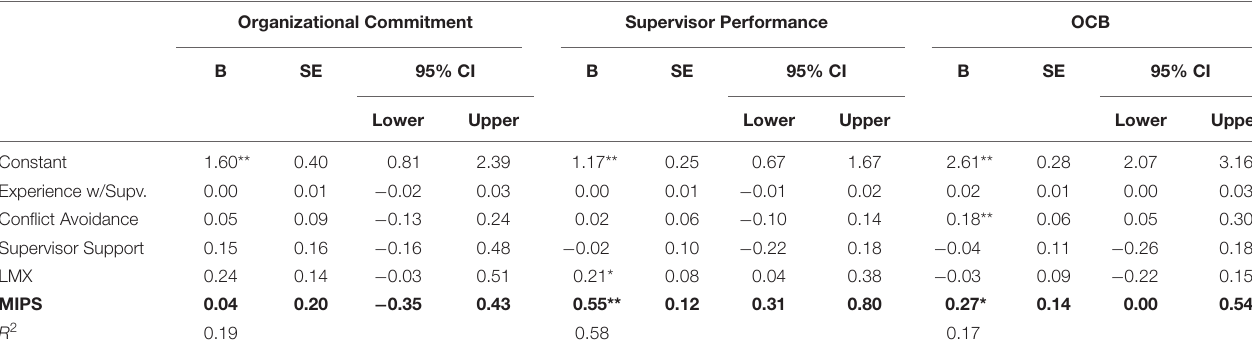
TABLE 5 | Criterion-Related Validity with MIPS – Study